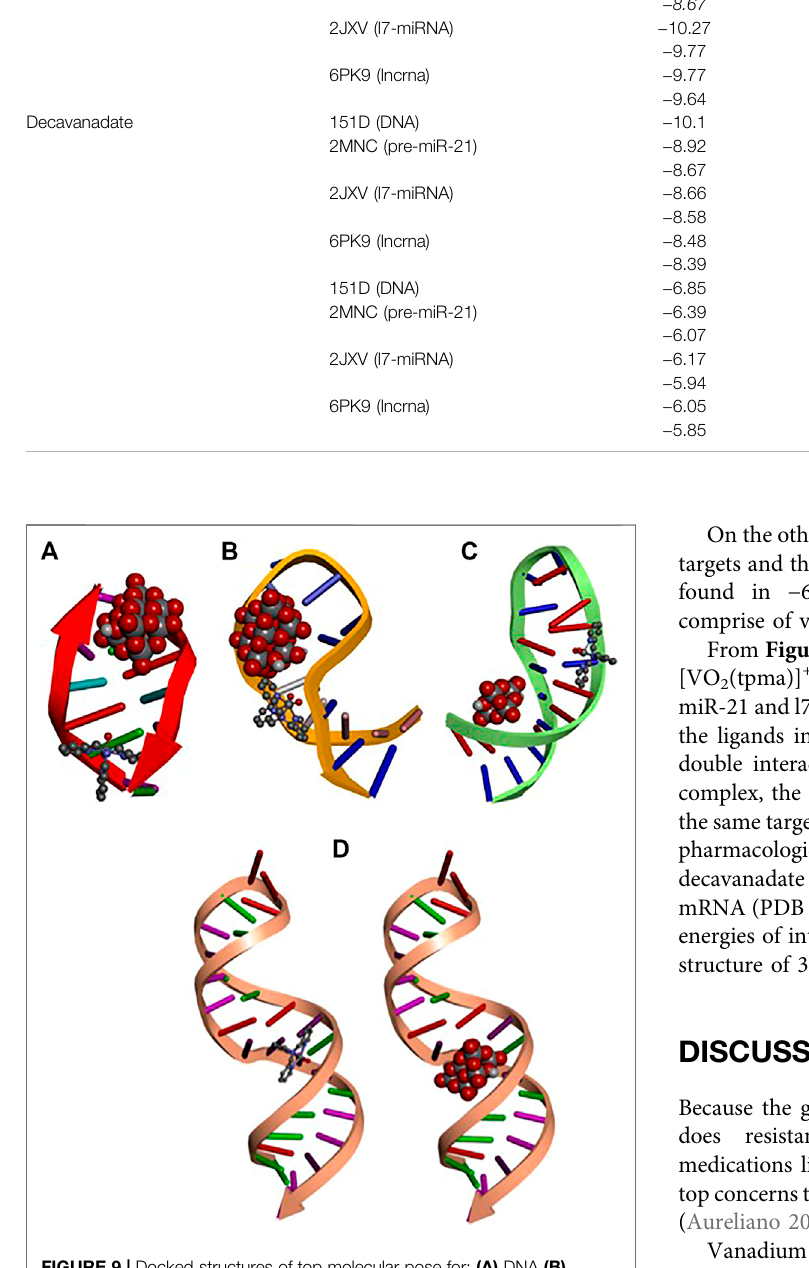
Frontiers in Chemistry |